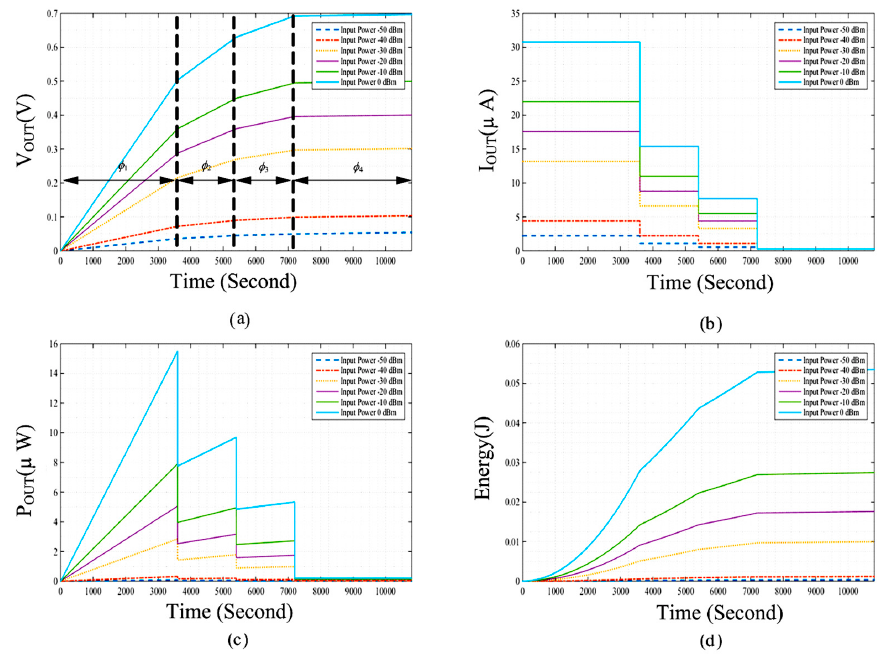
Figure 13. The measurement results of ( a ) Voltage across C STORE ; ( b ) Current through C STORE ; ( c ) Output power and ( d ) Stored energy.